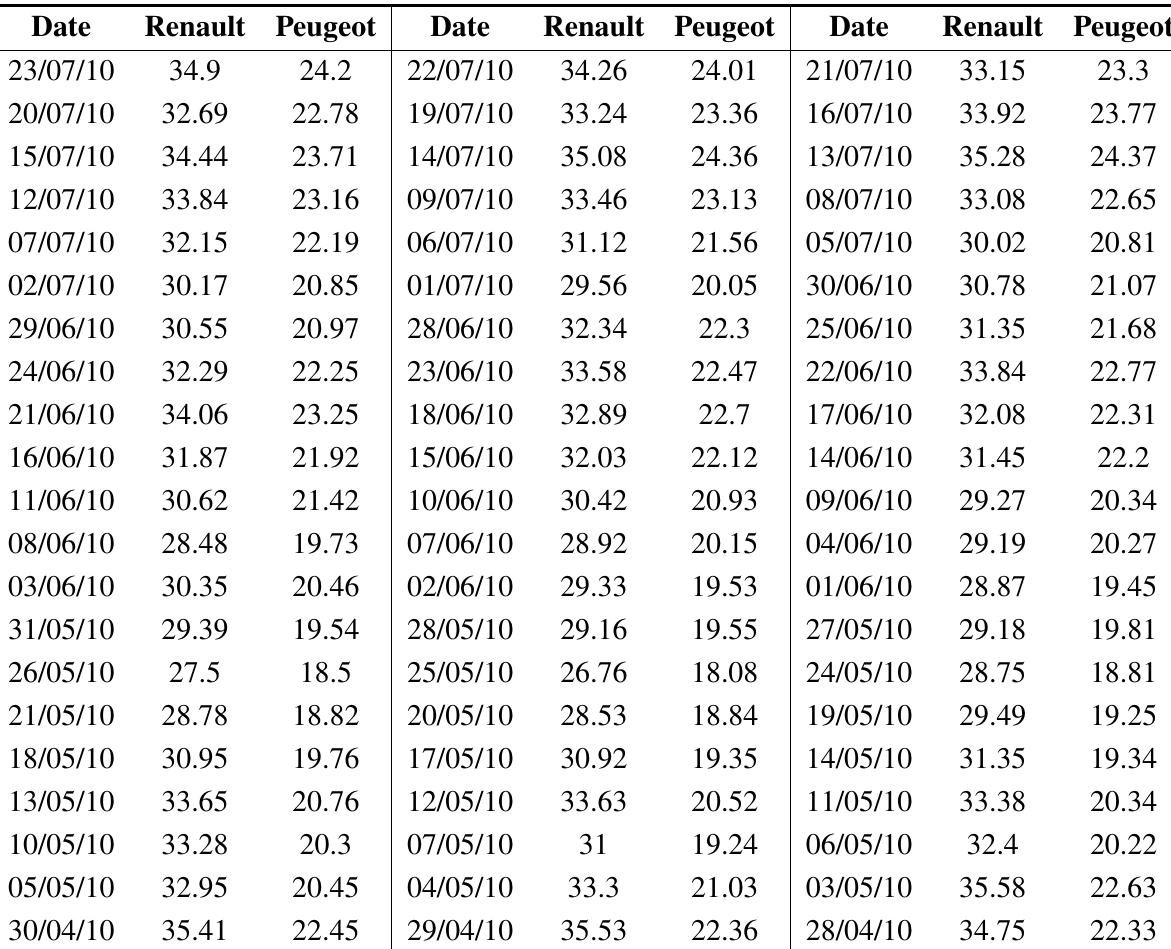
Table 7. Stock prices of Renault and